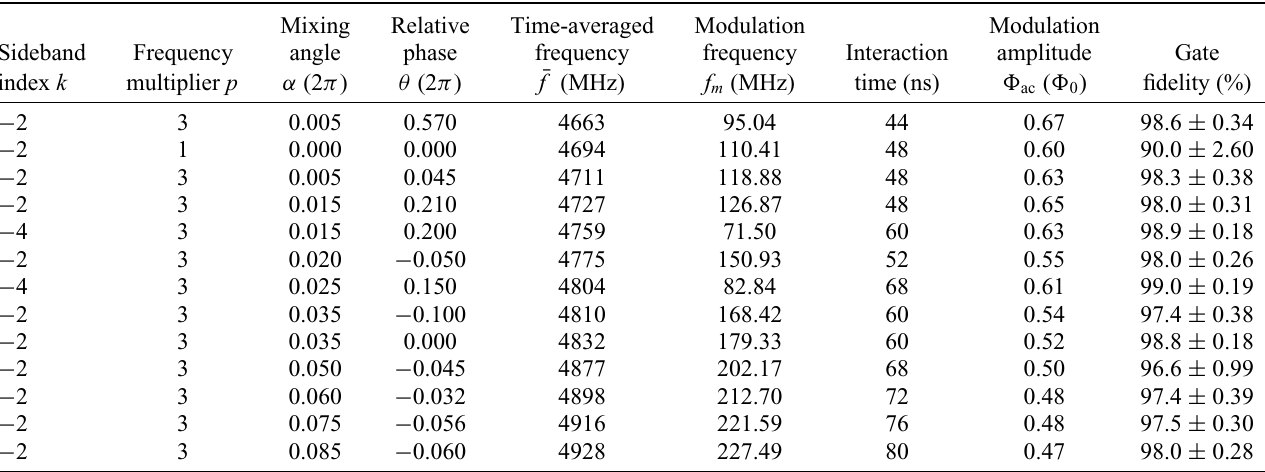
TABLE III. Information about the CZ 02 operating points and gates presented in Sec. IV and Fig. 9, listed in order of qubit 3’s of these operating points represent dynamical sweet spots with first-order protection against 1 / f flux noise.